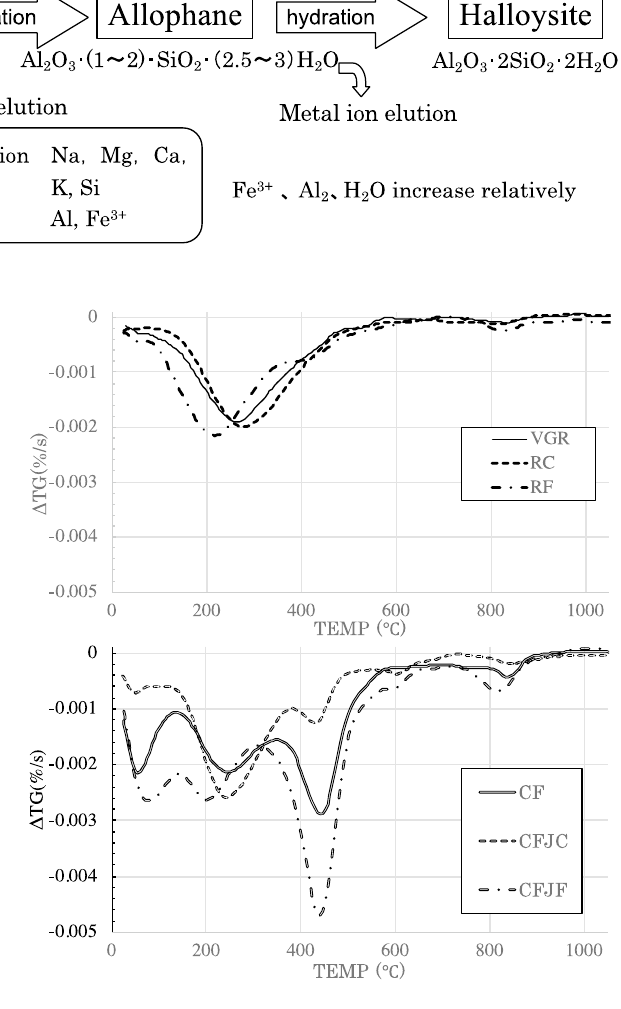
Fig. 11 Differential thermogravimetric curves of VGP and clay pow-